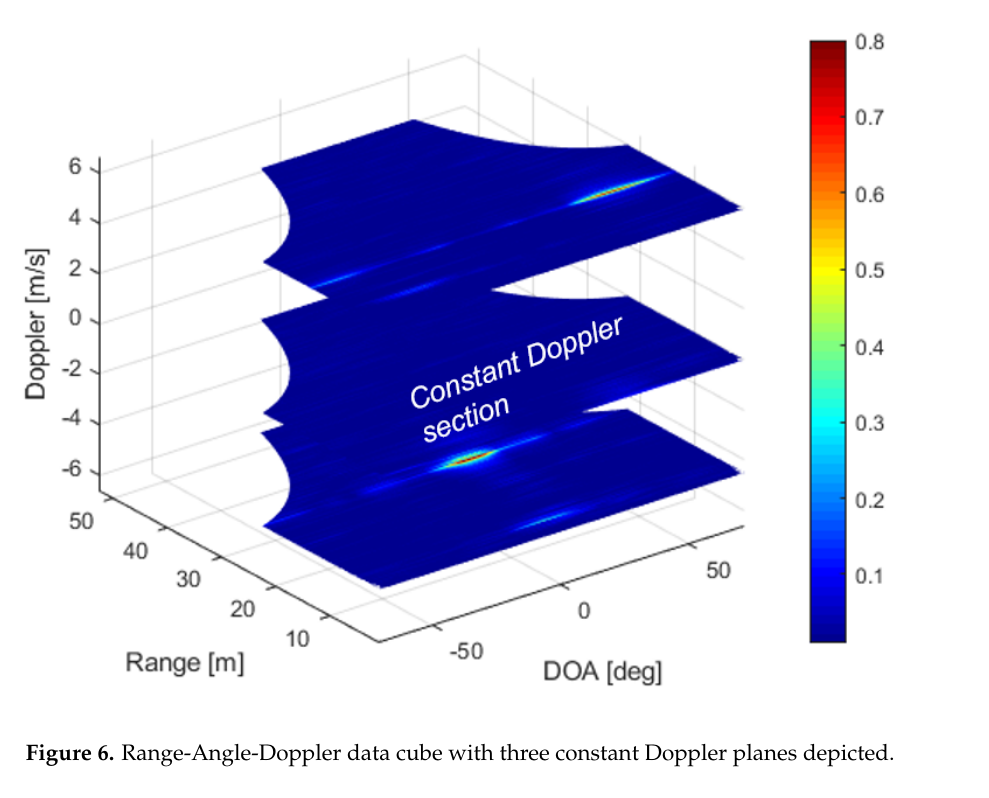
Figure 6. Range-Angle-Doppler data cube with three constant Doppler planes depicted.